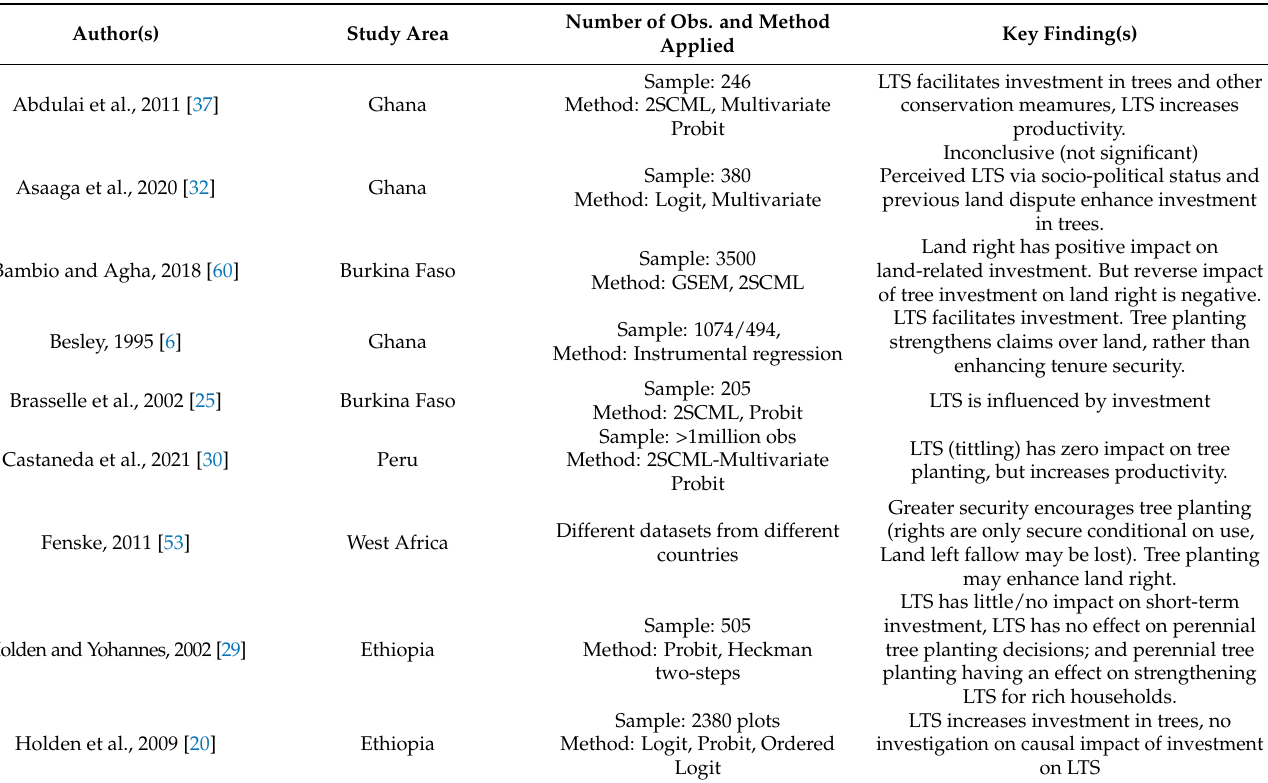
Table A1. List of studies relating to LTS and investment in tree